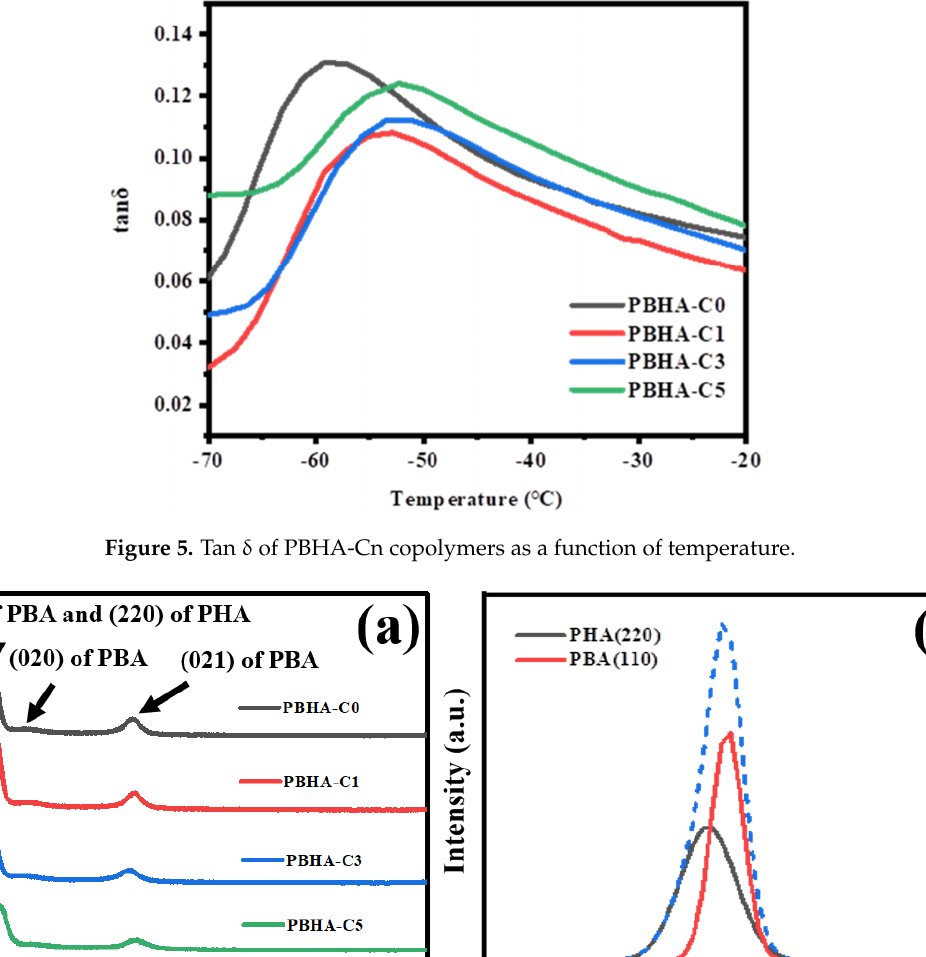
Figure 4. Weight loss as a function of temperature for PBHA-Cn copolymers.